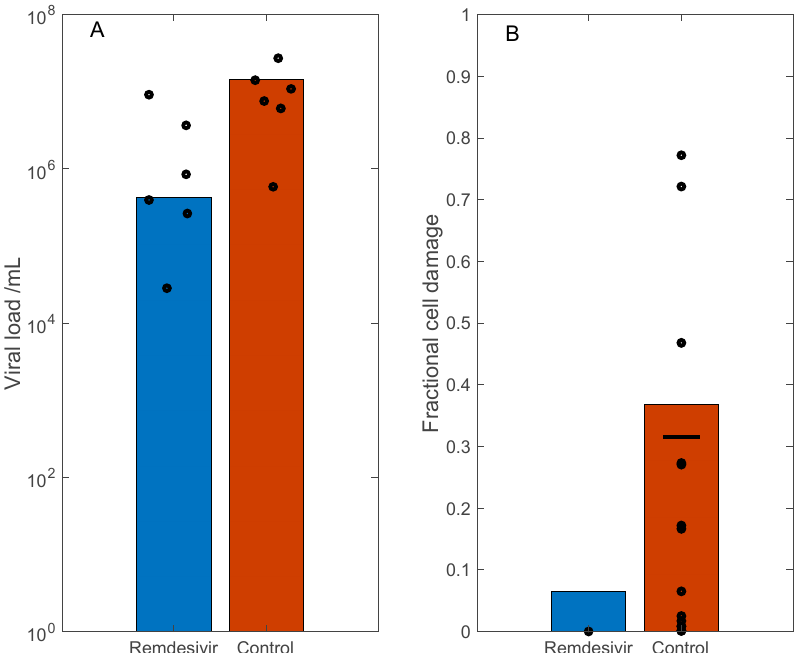
Figure 4. Simulation of SARS-CoV-2 dynamics in rhesus macaques, and the effect of Remdesivir, which inhibits viral transcription. Remdesivir was administered 12 h following initial viral exposure. Predicted viral load (Panel ( A )) and fractional cell damage (Panel ( B )), obtained for control (untreated) and Remdesivir-treated case, 3 days after initial exposure. Circles correspond to data from Ref. [22]. Horizonal bar in panel ( B ) denotes mean values of control data.